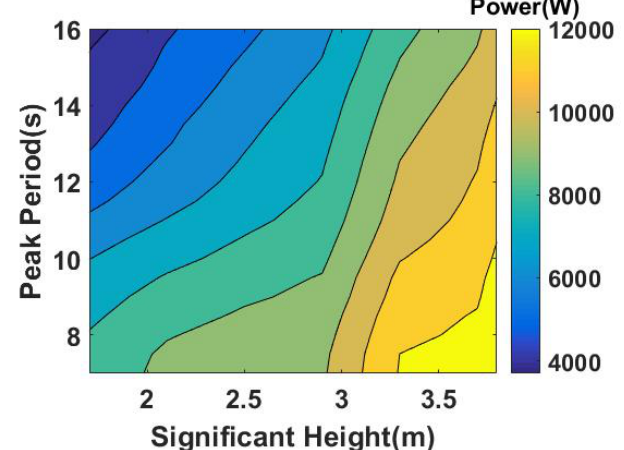
Fig. 13: The power extraction of different waves with a high control limitation.